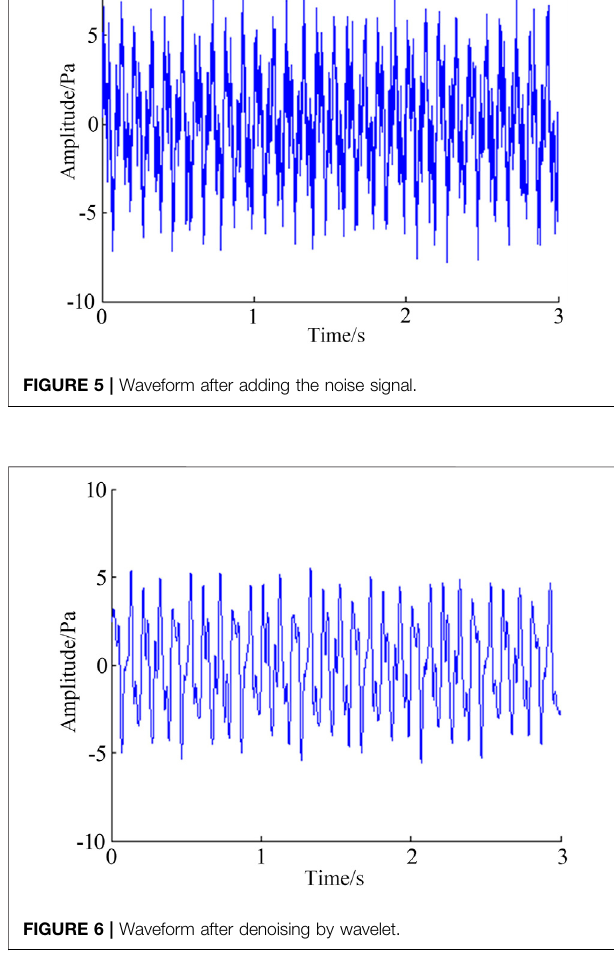
Figure 4 . The signal waveform after adding noise is shown in Figure 5 .